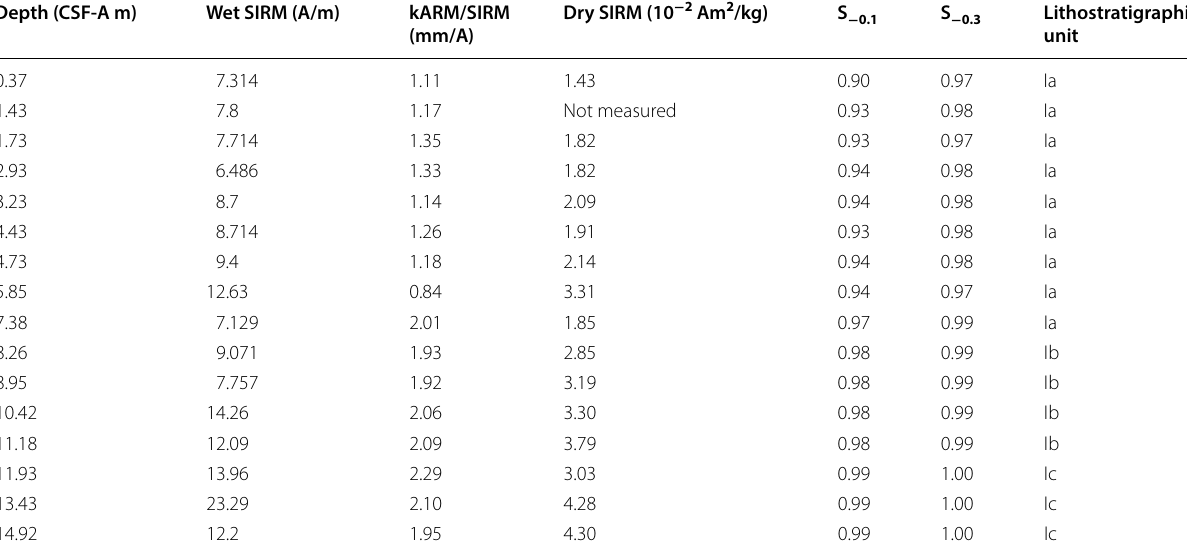
(Figs. 5, 6, 7) can be viewed as either monotonic increase or decrease. Therefore, the change in mag- netism may reflect mainly the change in the silicate Table 2 Summary of the magnetic properties of the untreated samples Depth (CSF-A